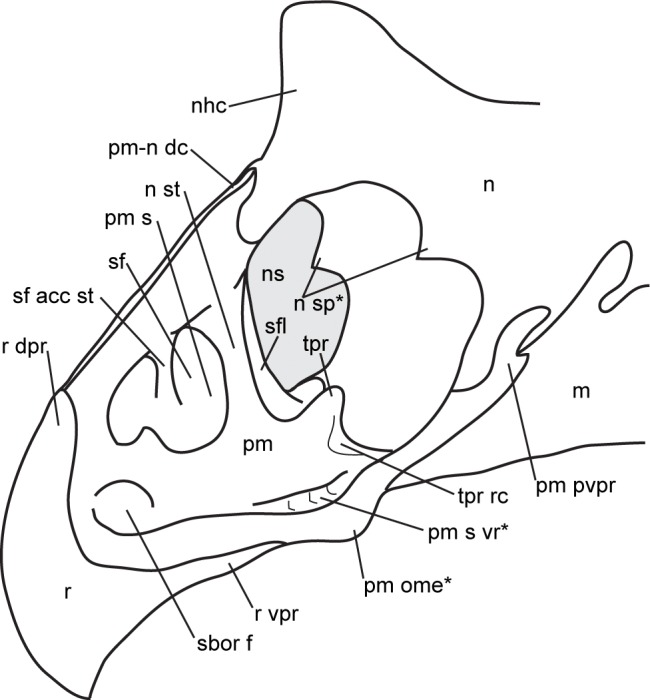
Schematic of an idealized chasmosaurine snout ([11]: Fig 8, modified).Centrosaurine features (i.e., not present in chasmosaurines) are indicated by asterisks (*) ([35]: fig 16.1). [planned for column width].